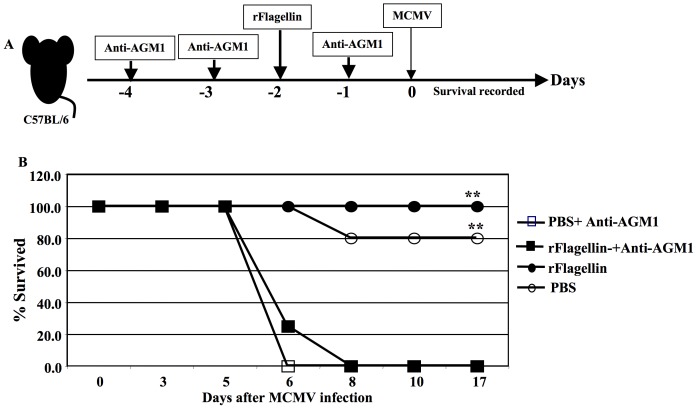
NK cells are required to induce enhanced early anti-mCMV immunity in rflagellin-treated mice.A). Experimental design of anti-asialo GM1 administration in WT B6 mice to deplete NK cells in vivo. Reconstituted anti-asialo GM1 in PBS and 0.5 ml was injected i.p to B6 mice on −4, −3 and −1 days of mCMV infection as described in Materials and Methods. Control WT B6 mice were injected with 0.5 ml PBS. 25 µg rflagellin was injected per mouse i.p 48 hours before mCMV infection in anti-asialo GM1-treated and or PBS treated WT B6 mice. All groups of treated mice were infected with a lethal dose (5×105 pfu/mouse) of mCMV i.p on day 0. B). Survival data were recorded by observing mice every day or mice were euthanized having weight loss >25% following mCMV infection and percent survived mice of each group are presented. This experiments was performed once using 8 to 10 mice per group. The symbol “**”represents the p value<0.005, Log Rank Test (Kaplan-Meier estimator).